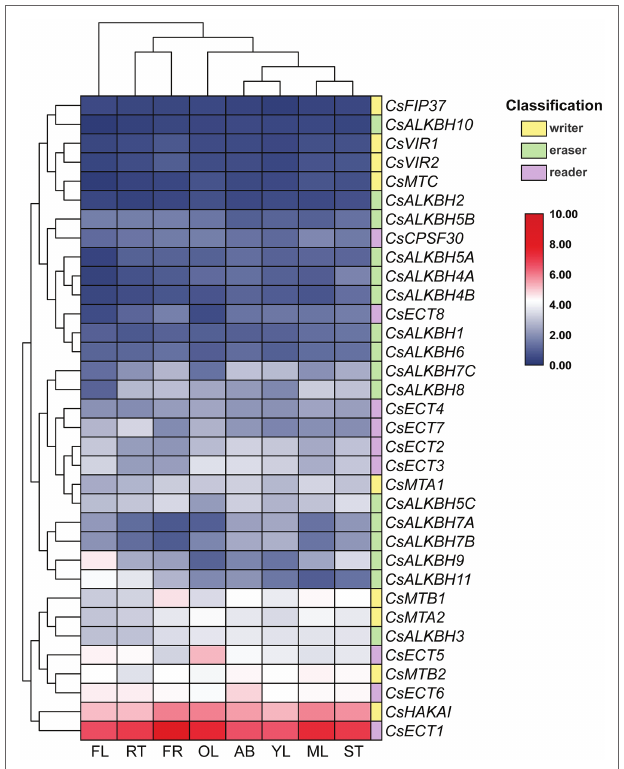
FIGURE 8 | Expression profiles of m6A regulatory genes in eight tea plant tissues. The expression values of m6A regulatory genes were normalized by log 2 -transformed (FPKM+1). FL: flowers; RT: roots; FR: fruits; OL: old leaves; AB: apical buds; YL: young leaves; ML: mature leaves; ST: stems. Public transcriptome data were collected from the NCBI Sequence Read Archive (SRA) database under accession number